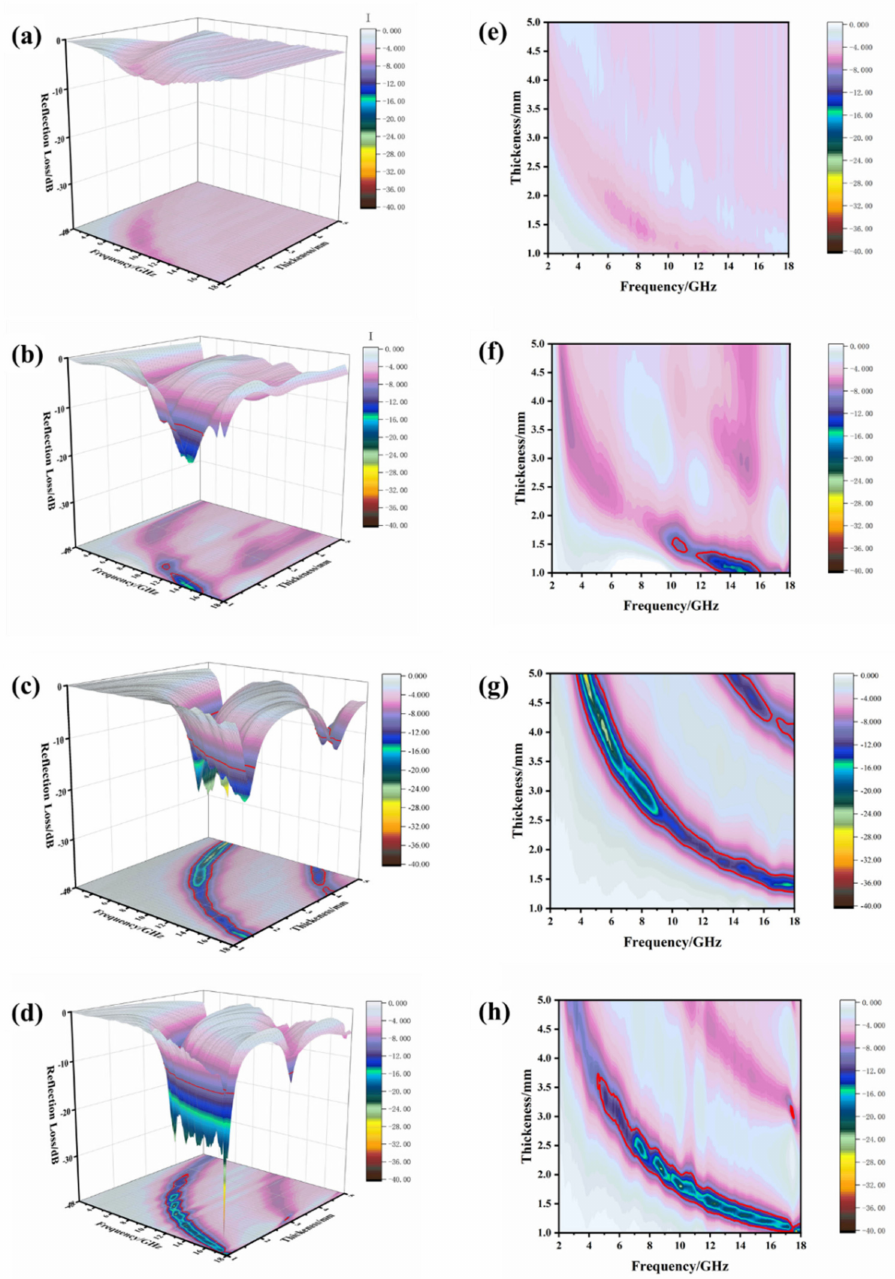
Figure 10. Three-dimensional diagrams and contour diagrams of the RL values of Fe 3 O 4 /MWCNT composite materials with different size of clusters: ( a , e ) 100 nm, ( b , f ) 200 nm, ( c , g ) 300 nm and ( d , h ) 400